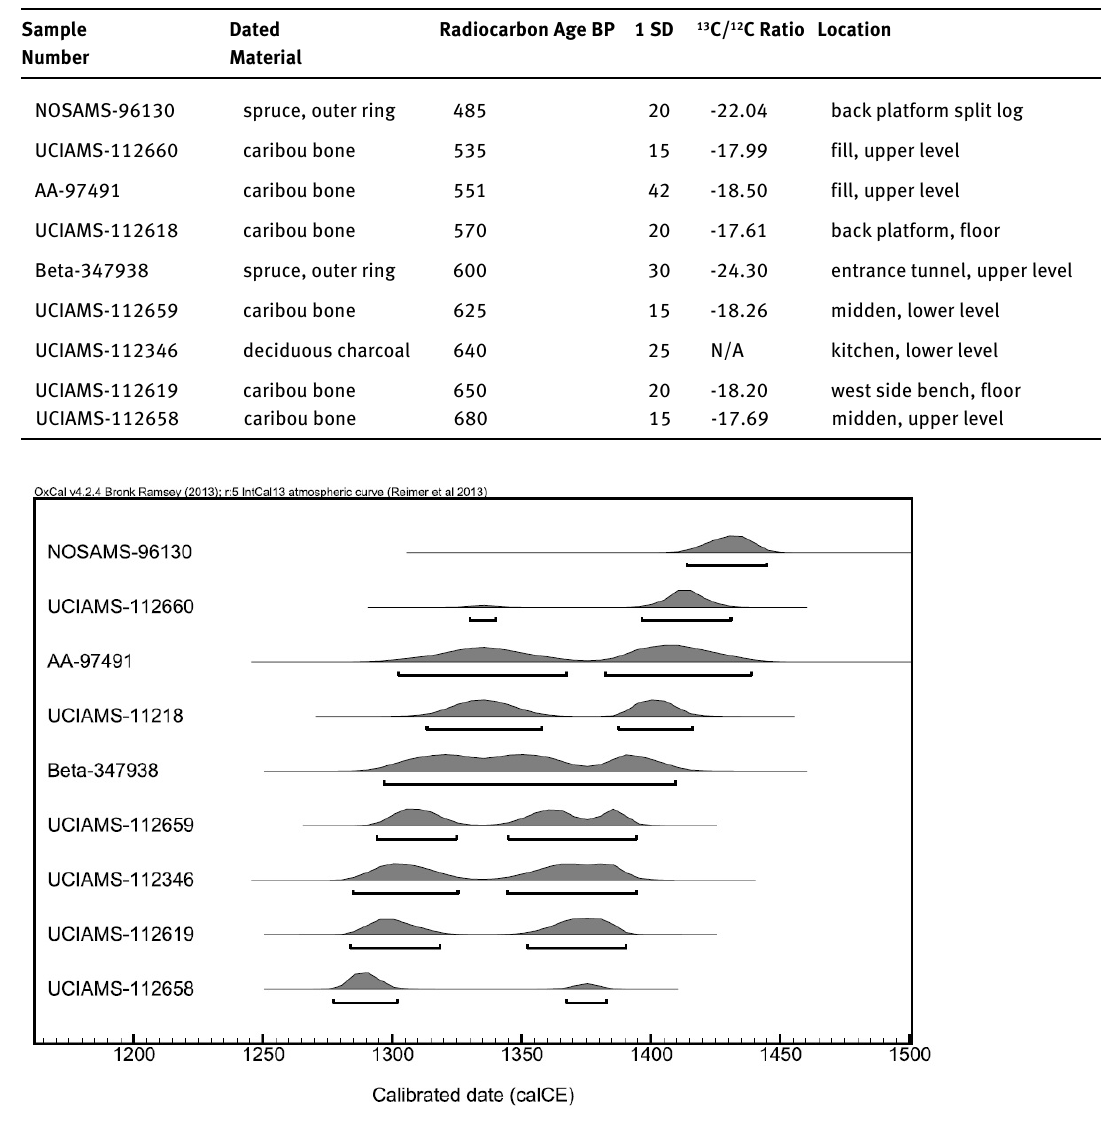
Figure 2: Calibrated radiocarbon dates for Feature